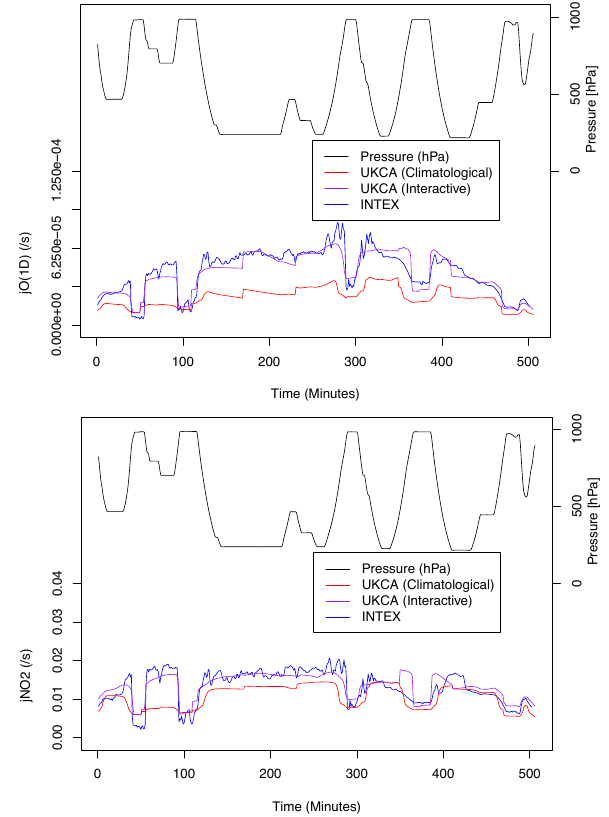
Fig. 3. Comparison of O 3 → O ( 1 D ) (top) and NO 2 (bottom) pho- tolysis rates during the first flight (1 July 2004) in the INTEX-A campaign between observations and the model with offline and in- teractive photolysis